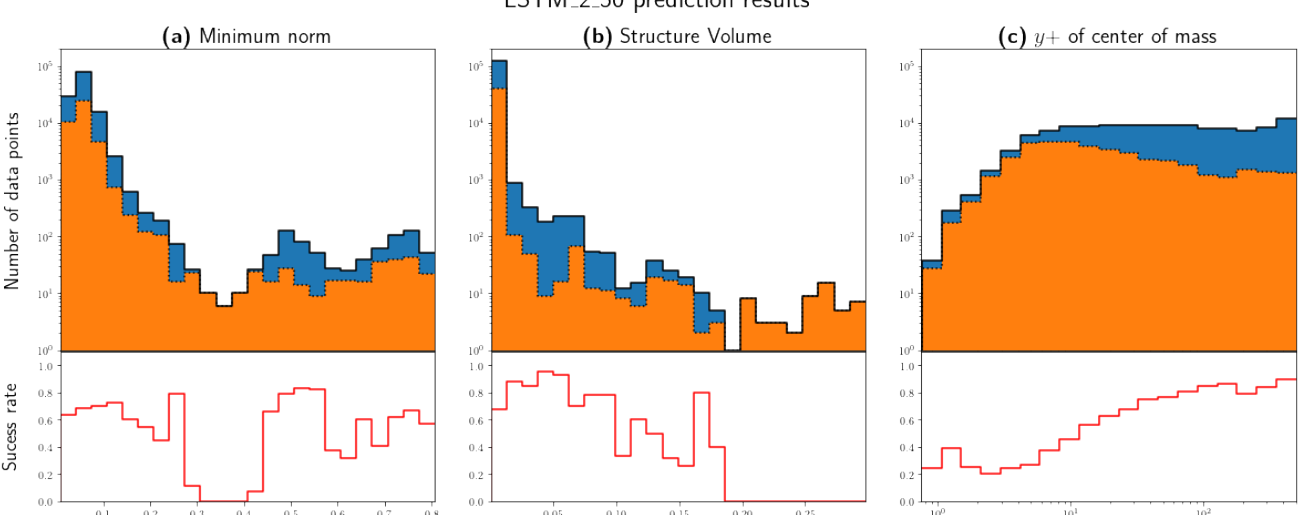
Figure 12. (cid:4) Successful predictions, (cid:4) Failed Predictions, - Total predictions, - Success rate. ( a ) Histogram of the LSTM_2_50 prediction results (up) and success rate (down) with respect to the norm of the difference between the predicted structure features vector and the one of the selected structure of the target time step; ( b ) Histogram of the LSTM_2_50 prediction results (up) and success rate (down) with respect to the original structure volume; and, ( c ) Histogram of the LSTM_2_50 prediction results (up) and success rate (down) with respect to the original structure y +